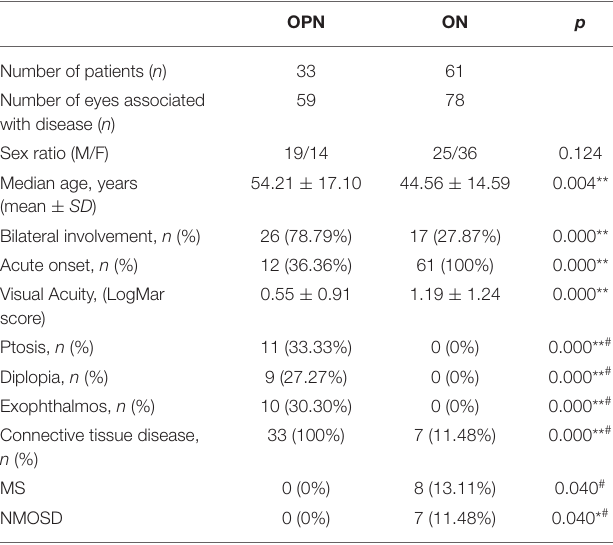
TABLE 2 | Clinical features of patients with OPN with autoimmune diseases vs. optic neuritis. OPN